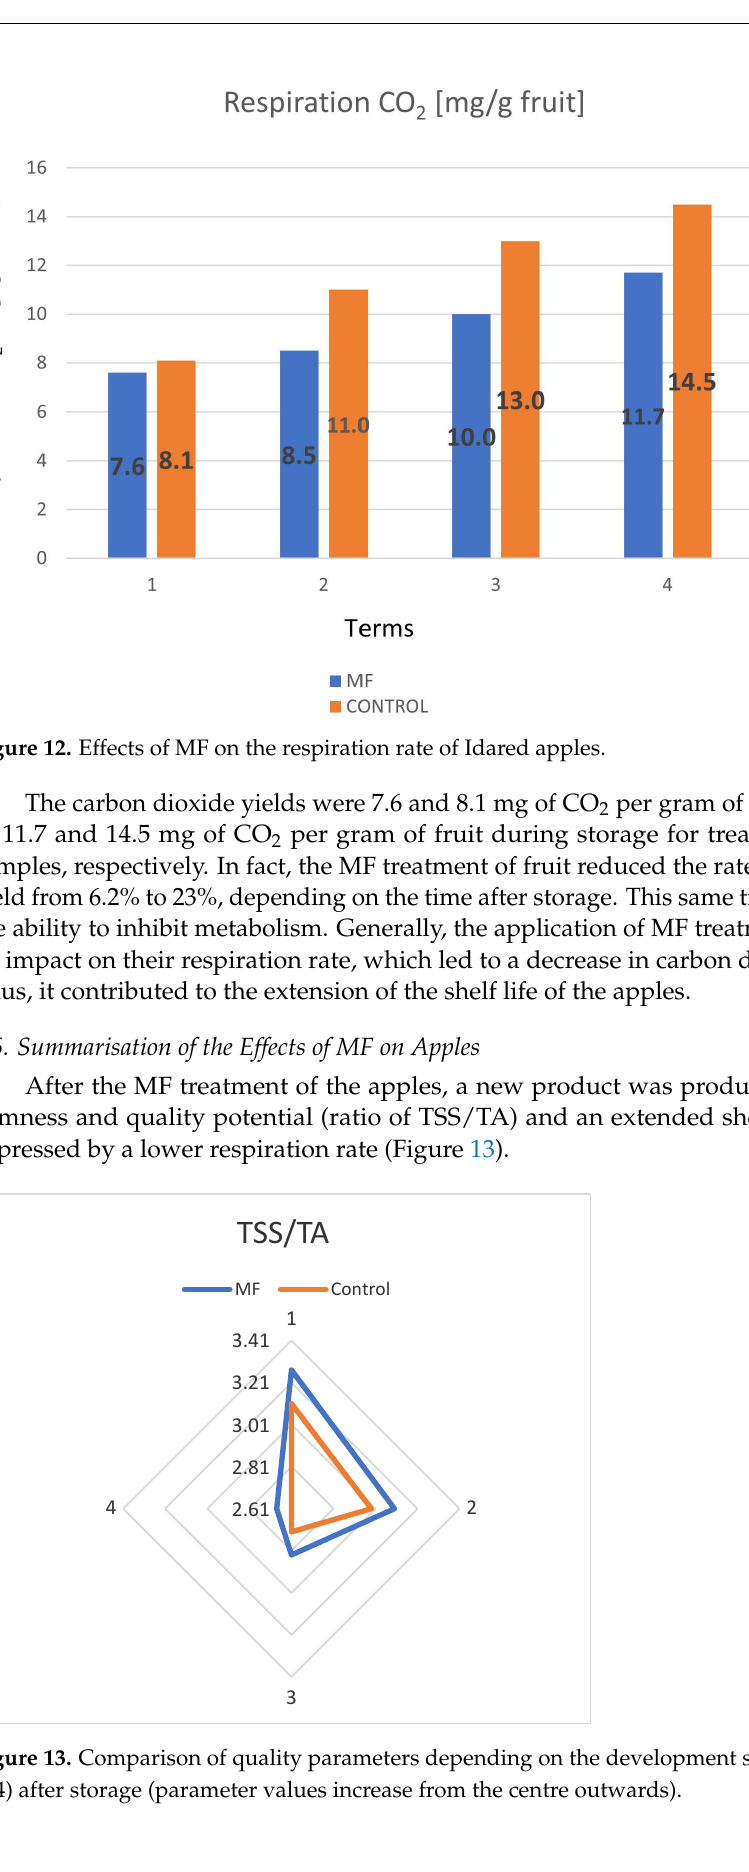
Figure 13. Comparison of quality parameters depending on the development stage of the fruit (1, 2, 3, 4) after storage (parameter values increase from the centre outwards).